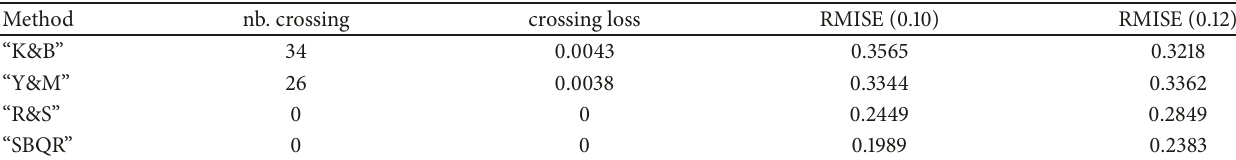
Table 1: Table of criteria: crossing loss and